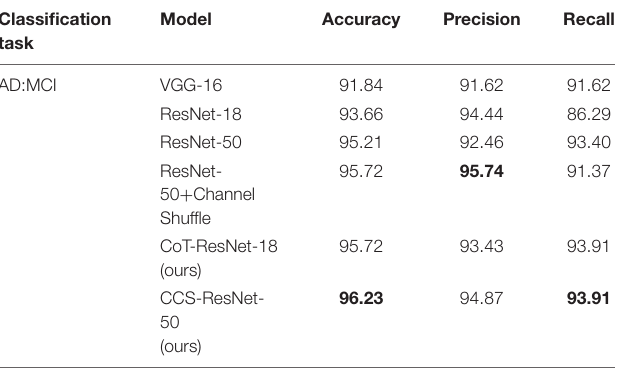
TABLE 4 | Experimental results of AD:MCI classification on MRI slices (unit: %).